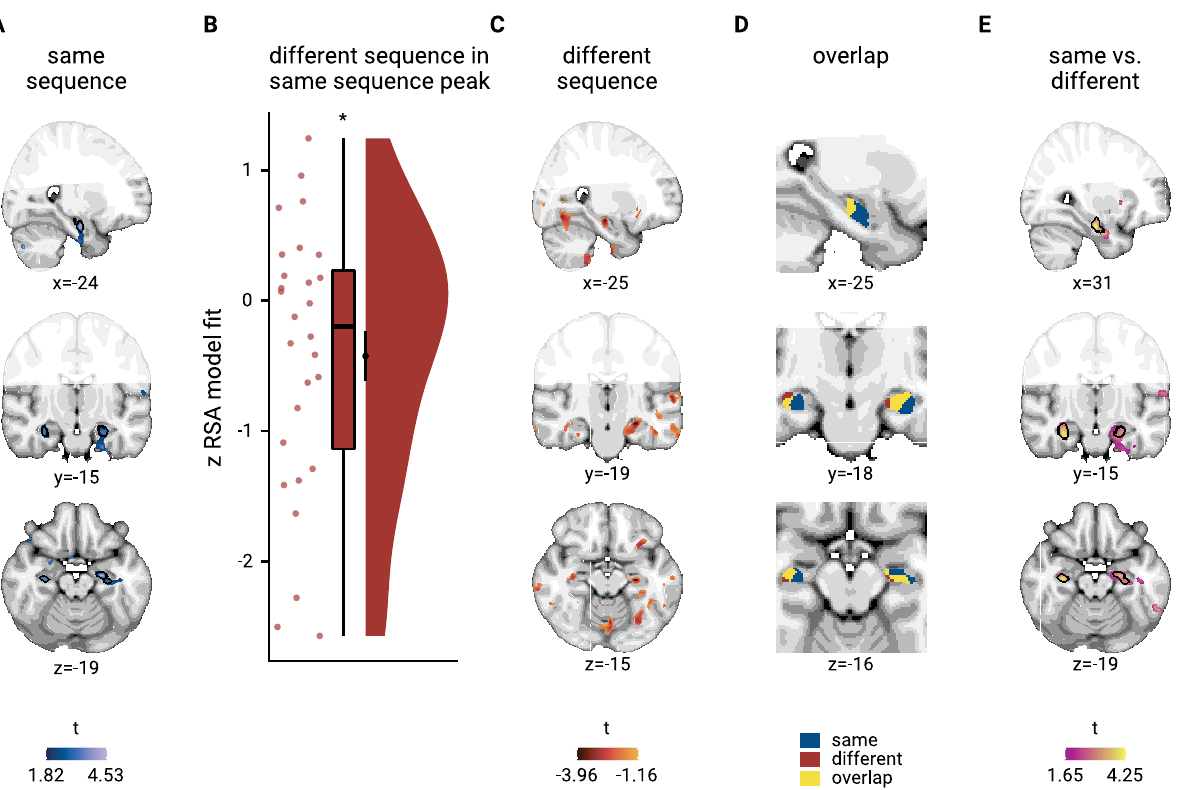
Fig. 7 Overlapping representations of within- and across-sequence relations. A Searchlight analysis results show a positive relationship between representational change and virtual temporal distances for event pairs from the same sequence in the bilateral anterior hippocampus. Statistical image is thresholded at p uncorrected < 0.01; voxels within black outline are signi fi cant after correction for multiple comparisons using small volume correction. B In the peak cluster from the independent within-sequence searchlight analysis ( A ), representational change was negatively related to virtual temporal distances between events from different sequences. Circles show Z-values from summary statistics approach for n = 28 participants; boxplot shows median and upper/lower quartile along with whiskers extending to most extreme data point within 1.5 interquartile ranges above/below the upper/lower quartile; black circle with error bars corresponds to mean ± S.E.M.; distribution shows probability density function of data points. C Searchlight analysis results show negative relationship between representational change and temporal distances for different-sequence event pairs. Statistical image is thresholded at p uncorrected < 0.05. D Within the anterior hippocampus, the effects for events from the same sequence and from two different sequences overlap. Visualization is based on statistical images thresholded at p uncorrected < 0.05 within small volume correction mask. E Searchlight analysis results show a bilateral interaction effect in the anterior hippocampus that is de fi ned by a differential relationship of virtual temporal distances and representational change for events from the same and different sequences. Statistical image is thresholded at p uncorrected < 0.01; voxels within black outline are signi fi cant after correction for multiple comparisons using small volume correction. A , C – E Results are shown on the MNI template with voxels outside the fi eld of view displayed in lighter shades of gray. See Supplementary Fig. 9 for additional exploratory results. Source data are provided as a Source Data fi